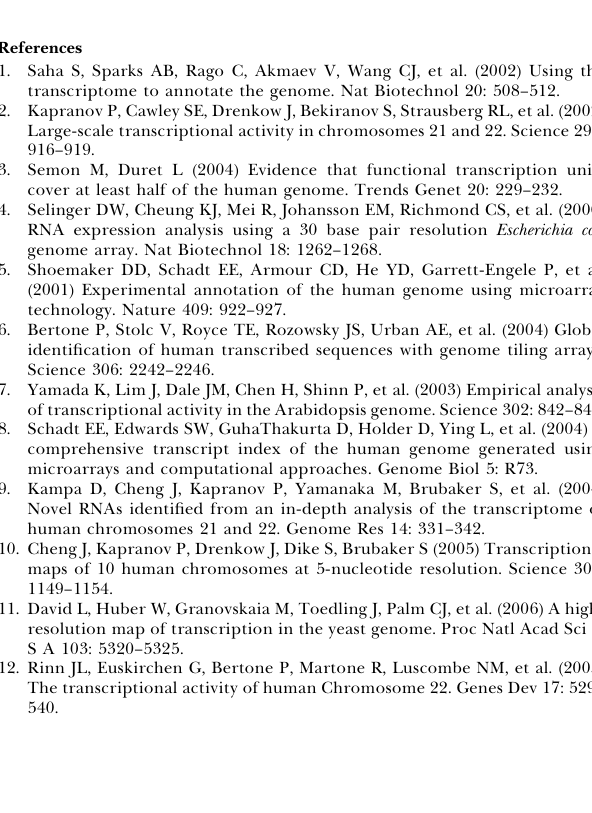
Table S6. Properties of Primers Used in Q-PCR